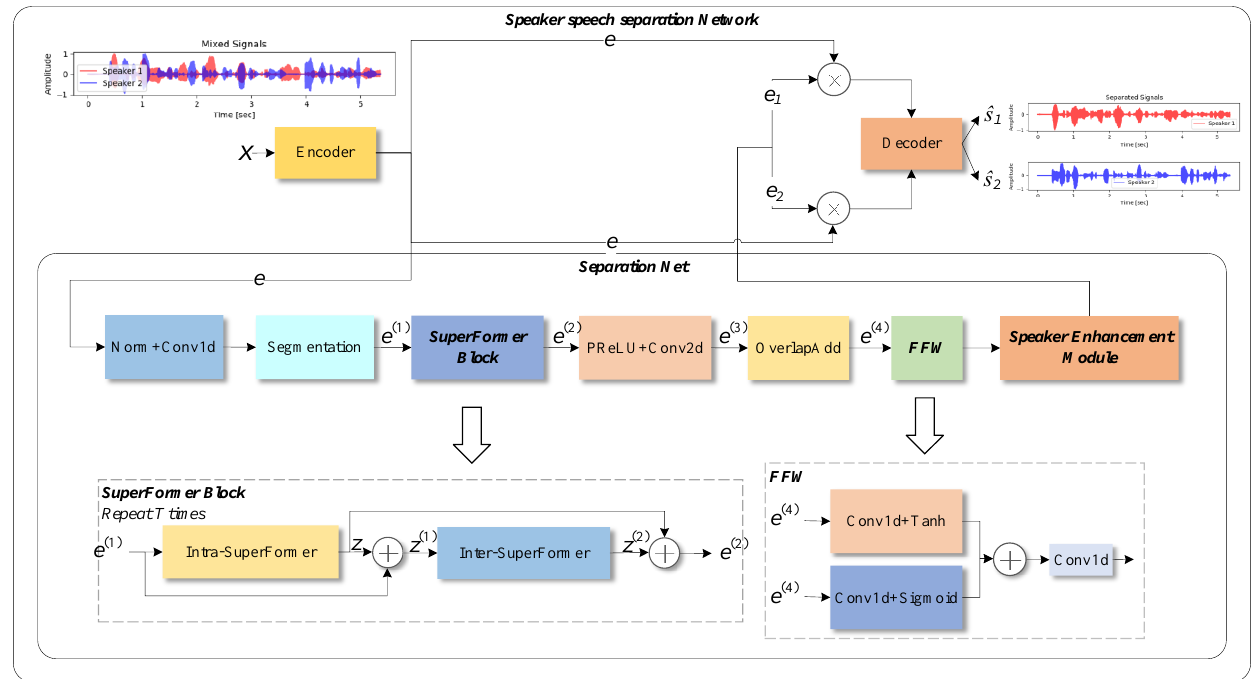
Figure 1. Overall technical route of speech separation system.